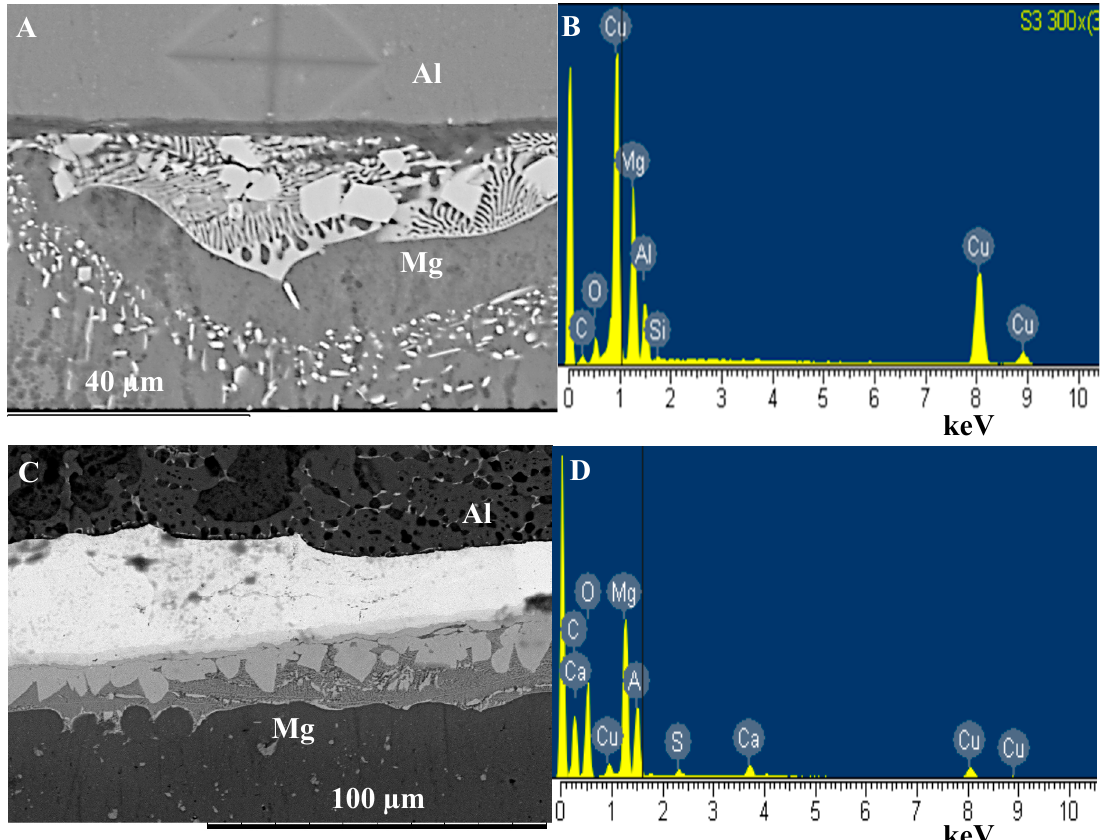
Figure 4. Eutectic microstructure formed at the joint interface during diffusion brazing. ( A ) Eutectic microstructure formed using pure-Cu. ( B ) Energy dispersive spectroscopy (EDS) spectrum of region-1. ( C ) Eutectic microstructure formed using Cu/Al 2 O 3 interlayer. ( D ) EDS spectrum of